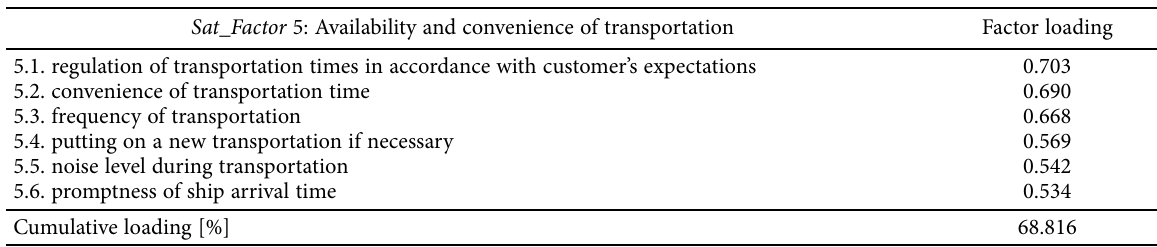
Table 8. Satisfaction Factor 5 factor loadings